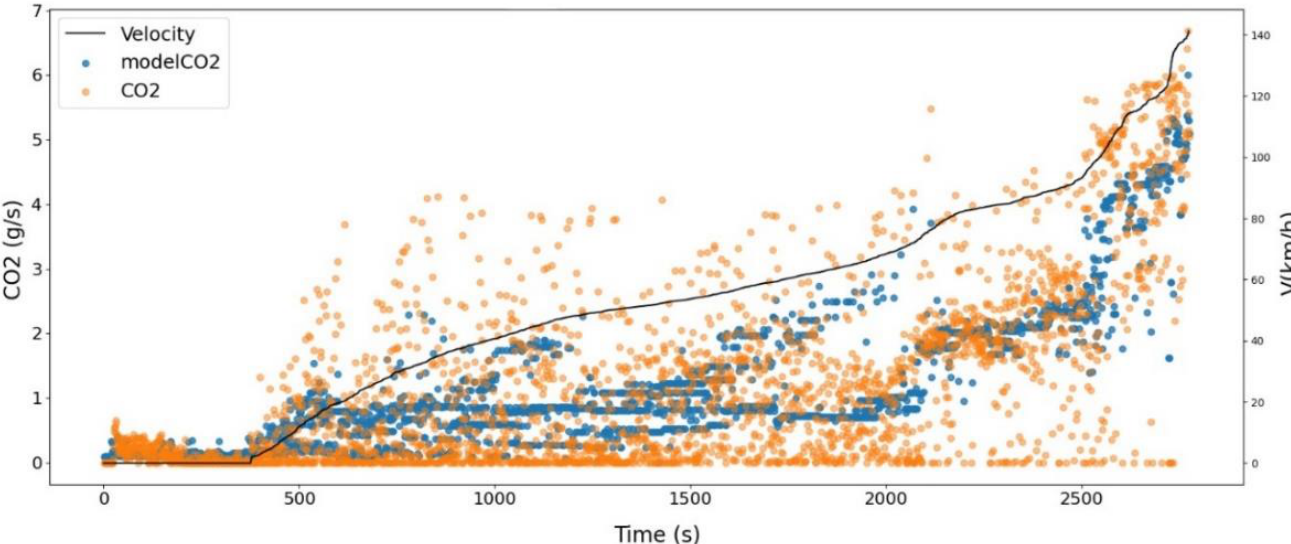
Figure 9. Instantaneous CO 2 emissions from an LPG vehicle for model data (blue) and actual data (orange) sorted by increasing vehicle speed (black line) for the entire test run. Table 1. Results of validation of a CO 2 emission model using MSE and R 2 for the gradient boosting machine learning technique for an LPG vehicle.